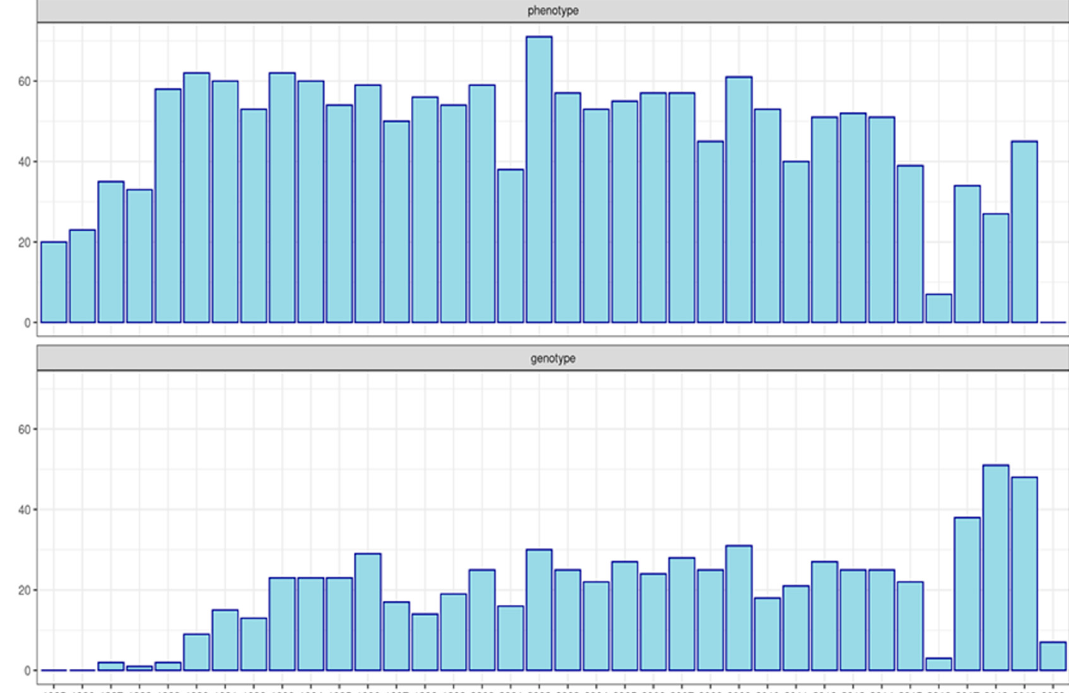
Figure 1. Number of animals with the phenotype ( above ) and number of animals with the genotype ( bottom ) for all animals used in genetic or genomic prediction. X-axes represent the birth years and y-axis the number of animals per year.